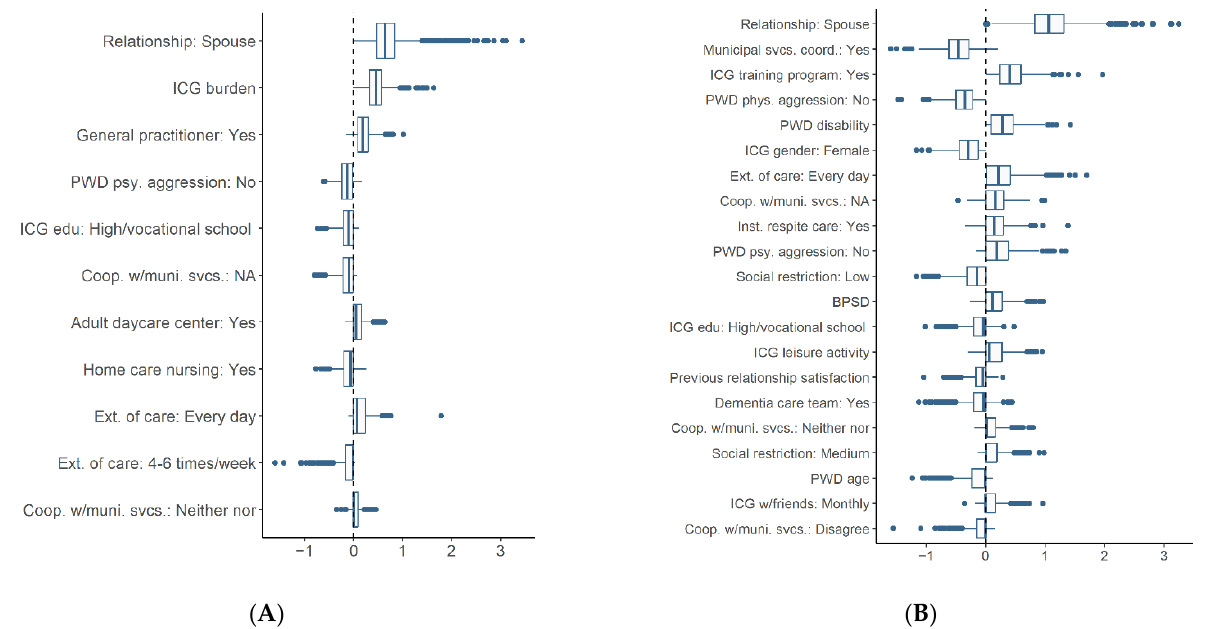
Figure 5. Boxplots of standardized regression coefficients for variables selected by lasso in >50% of 1000 bootstrap samples. Outcome variables: ( A ) psychological abuse; ( B ) physical abuse. Median (horizontal line), 50% middle values (quartile 2 – 3) (box), extremities (±1.5 interquartile range) (whiskers), outliers (dots).